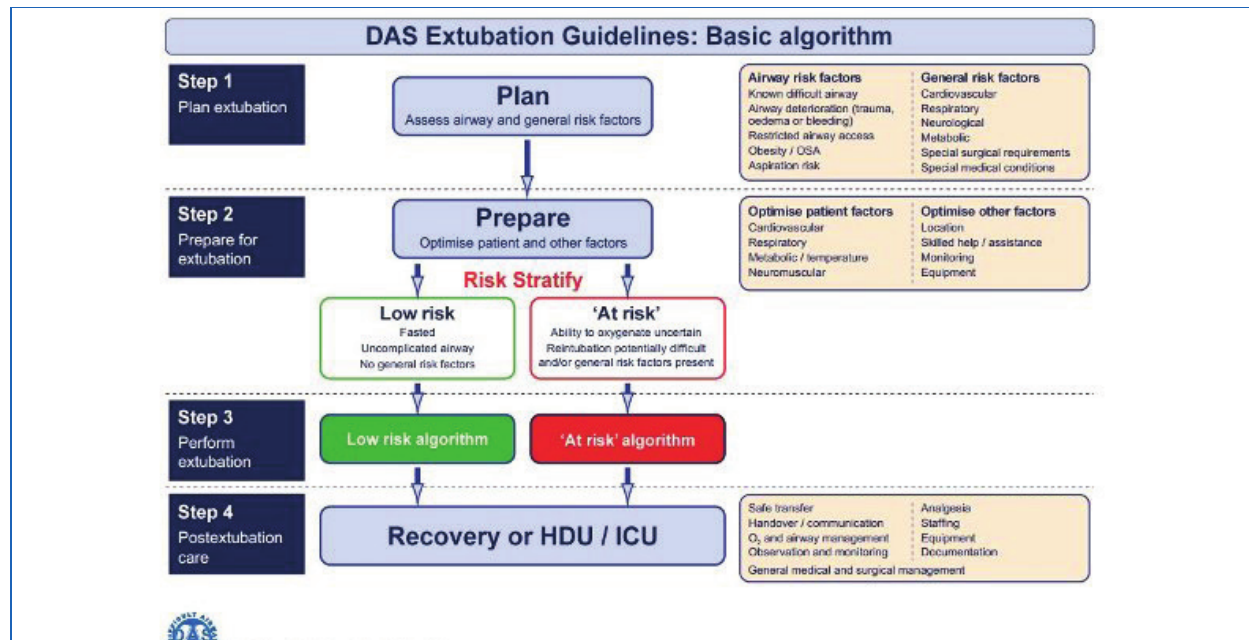
Figure 9. DAS Extubation